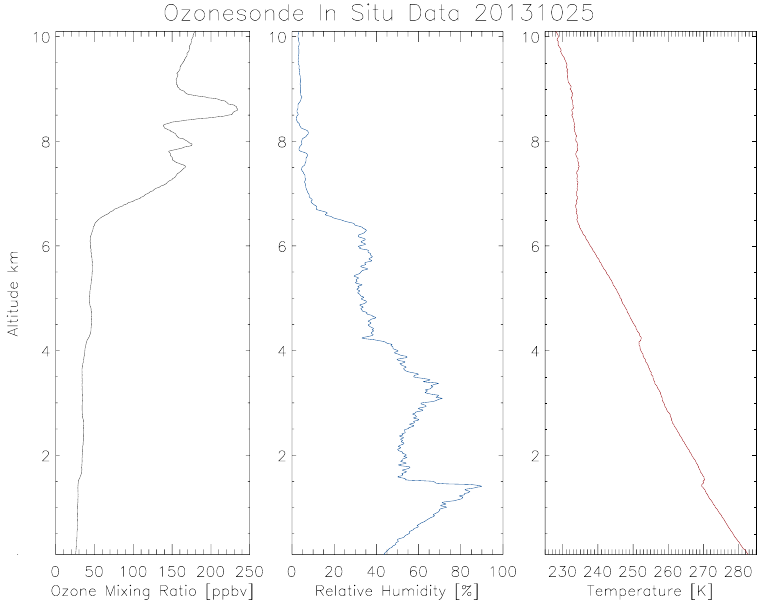
Figure 7. The radiosonde and ECC in situ data for ozone mixing ratio, relative humidity, and temperature plotted for the test case on 25 October 2013. (Source: Howard University Beltsville Center for Climate Systems